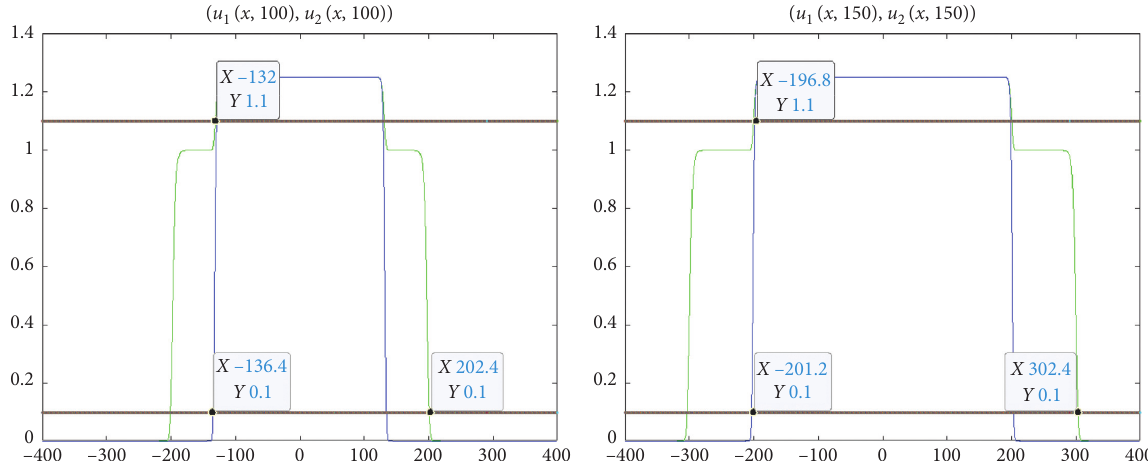
Figure 6: Spatial plots of u